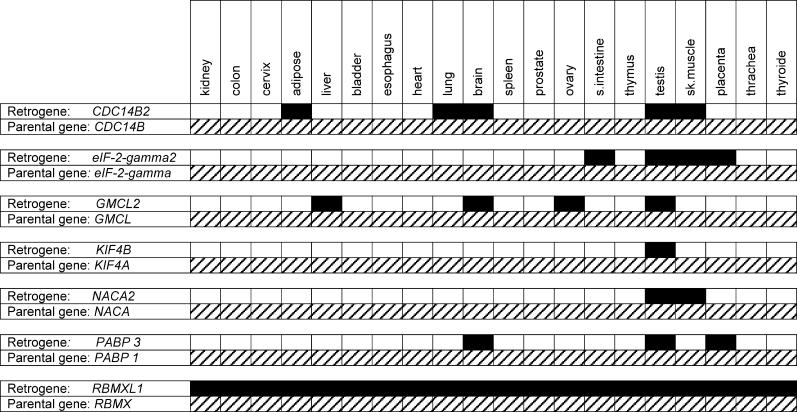
Expression Pattern of Retrogenes and Parents Determined by RT-PCRBlack boxes indicate retrogenes; hatched boxes indicate parental genes. Note that in all cases testis expression of the retrogene was the strongest, as indicated by the semiquantitative PCR procedure (data not shown).